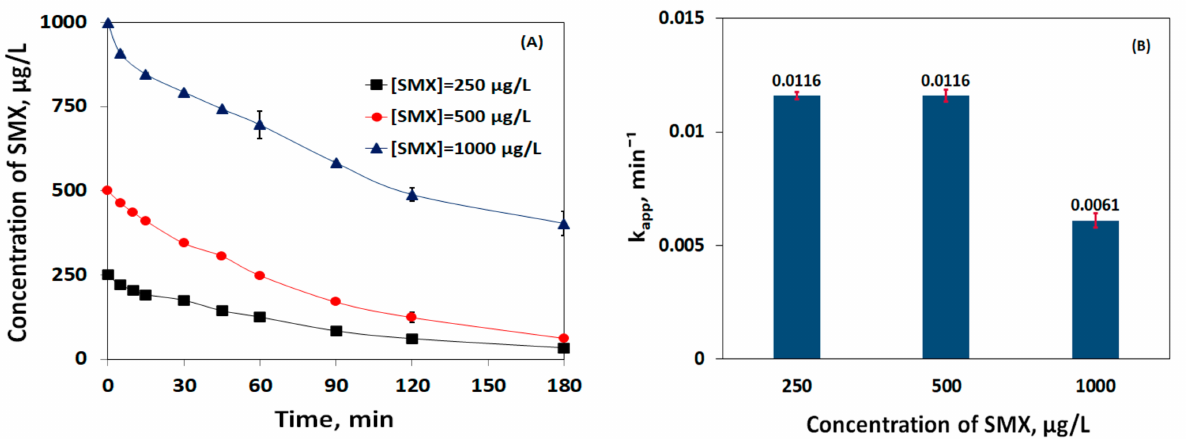
Figure 6. ( A ) Impact of SMX loading on its decomposition, [0.50 CoP/BVO] = 1000 mg/L, [SMX] = 500 µ g/L, pH = 5.5, UPW. ( B ) Apparent rate